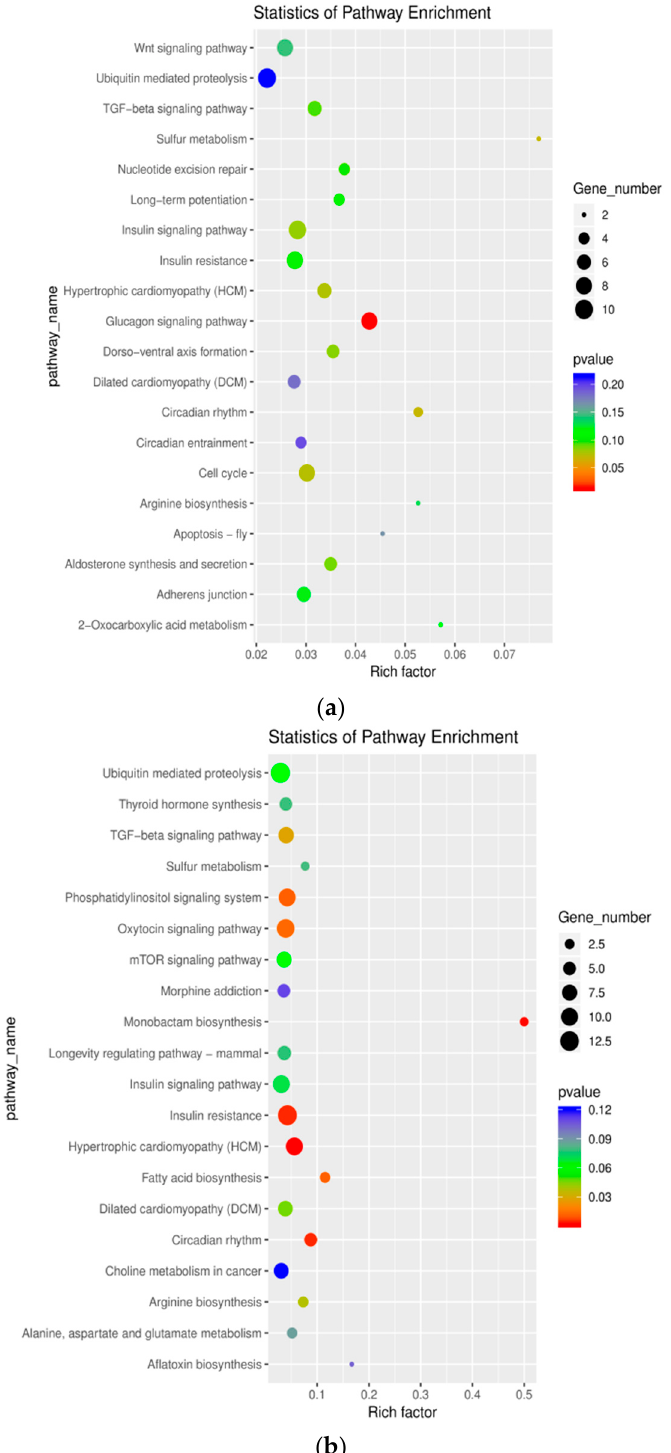
Figure 8. Significantly enriched KEGG terms of the ceRNA network. (a): WB vs SB. (b): WT vs ST. Y-axis: pathway name; X-axis: enrichment factor; Bubble size reflects the number of differential expressions enriched to a certain pathway/all quantities in the background; Color reflects the significance of differential expression in a certain process. WB, WT, SB, and ST represent WuTou donkey longissimus dorsi muscle, WuTou donkey gluteus muscle, SanFen donkey longissimus dorsi muscle, and SanFen donkey gluteus muscle, respectively.